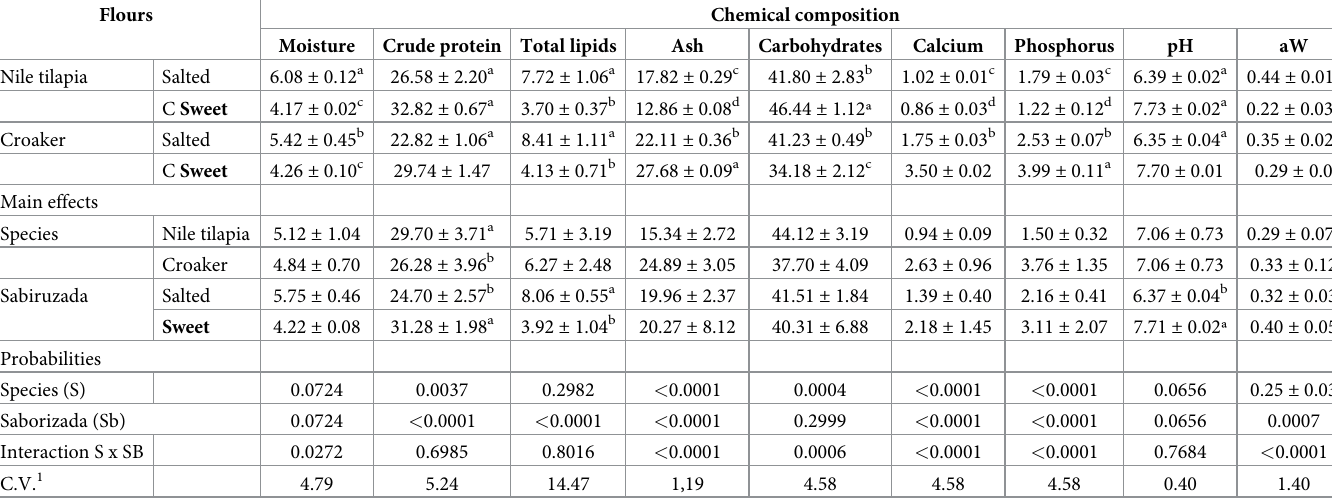
Averages in the same column followed by standard deviation with different lowercase letters are different from each other by Tukey’s test and Student’s t test. (P < 0.05); 1 C.V. = coefficient of